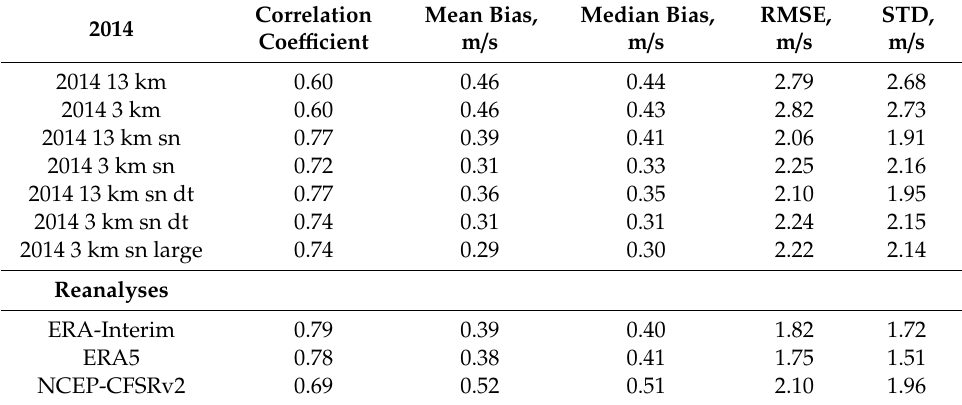
Table 2. Statistical scores of experiments verification results for the August–September 2014 period, 10 m